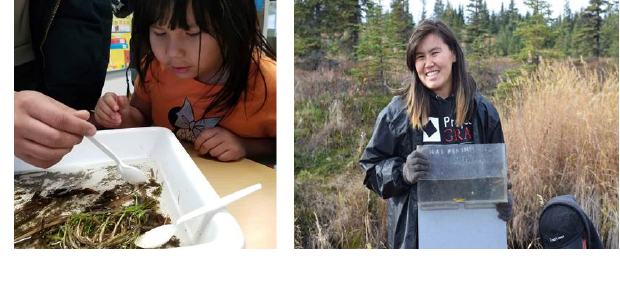
Fig. 7. Photos showing students from the Tebughna School in the village of Tyonek participating in research, education programs, and local knowledge sharing with Kachemak Bay National Estuarine Research Reserve